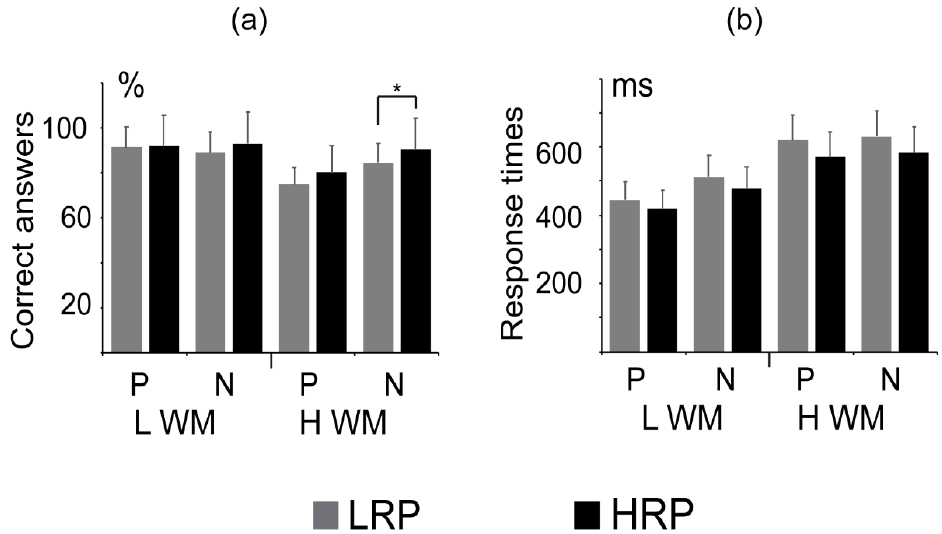
Figure 2. Means and standard deviations of the percentage of: ( a ) correct answers and ( b ) response times, for high- and low-load working memory sets (L WM and H WM, respectively) for positive (P) and negative (N) probes. Note that both groups displayed significantly lower percentages of correct answers for the H WM than for the L WM condition. This effect was larger for the group with low reading performance (LRP, represented in gray bars) than for the high reading performance group (HRP, black bars); * p < 0.05.